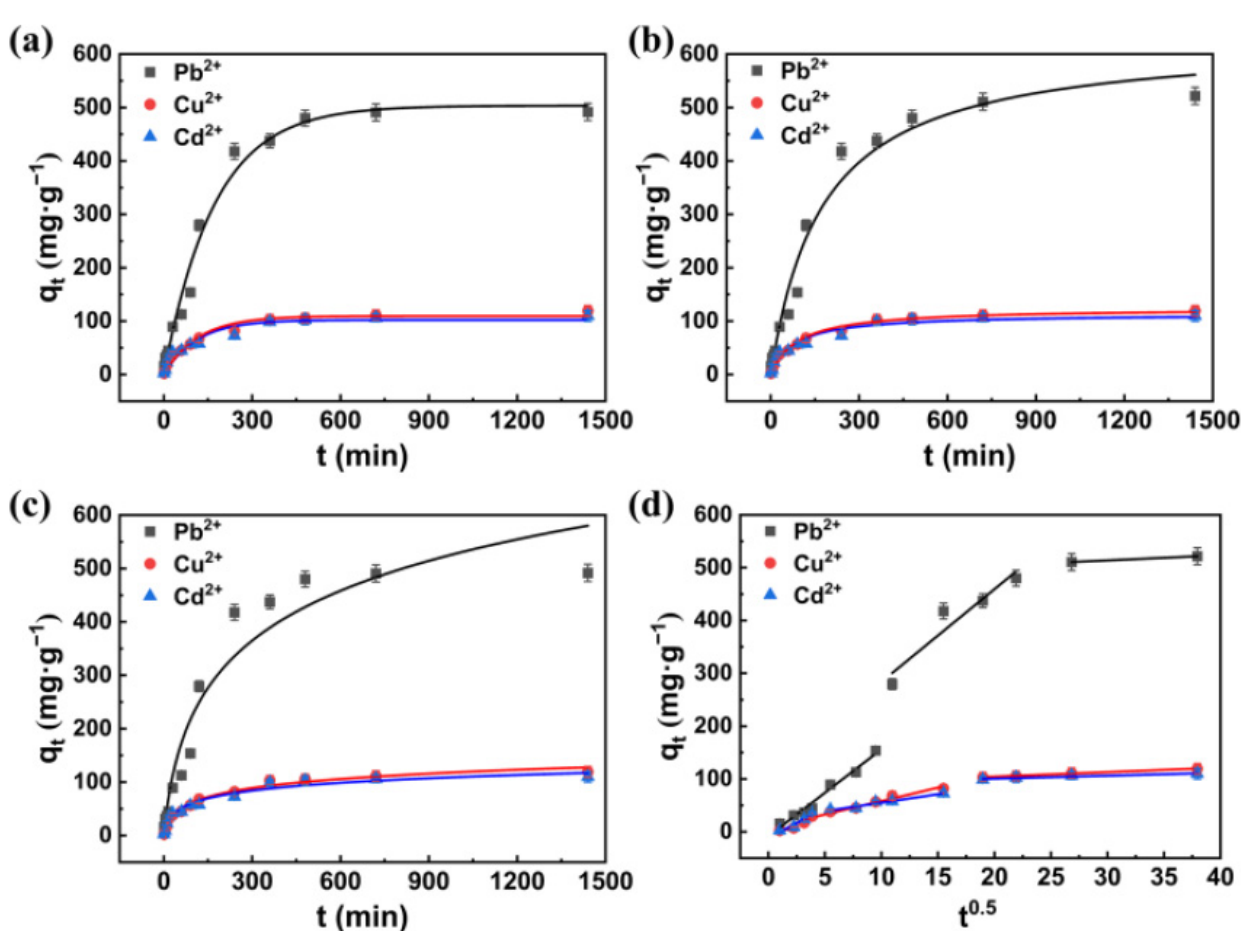
Figure 9. Fitting curves of adsorption kinetics. ( a ) pseudo-first-order kinetics model. ( b ) pseudo-second-order kinetics model. ( c ) Elovich model. ( d ) intra-particle diffusion model.